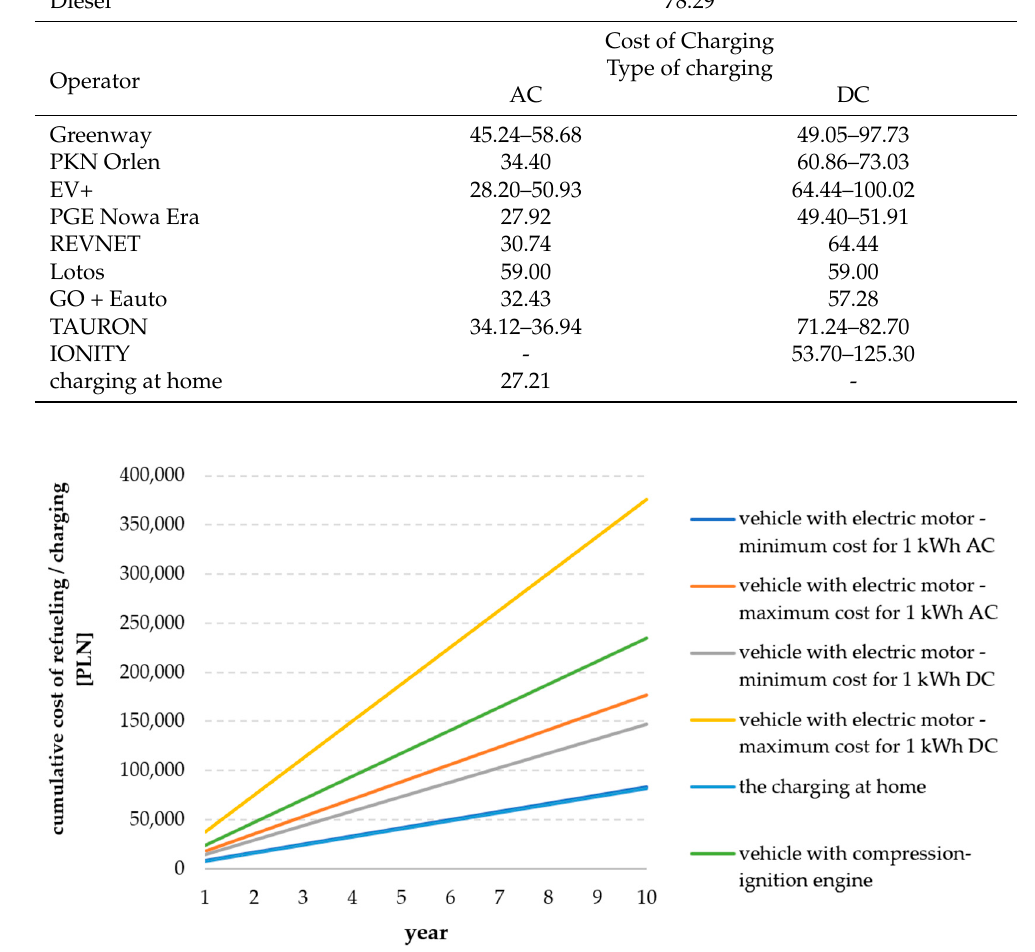
Figure 14. The cumulative cost of refuelling/charging of the analysed